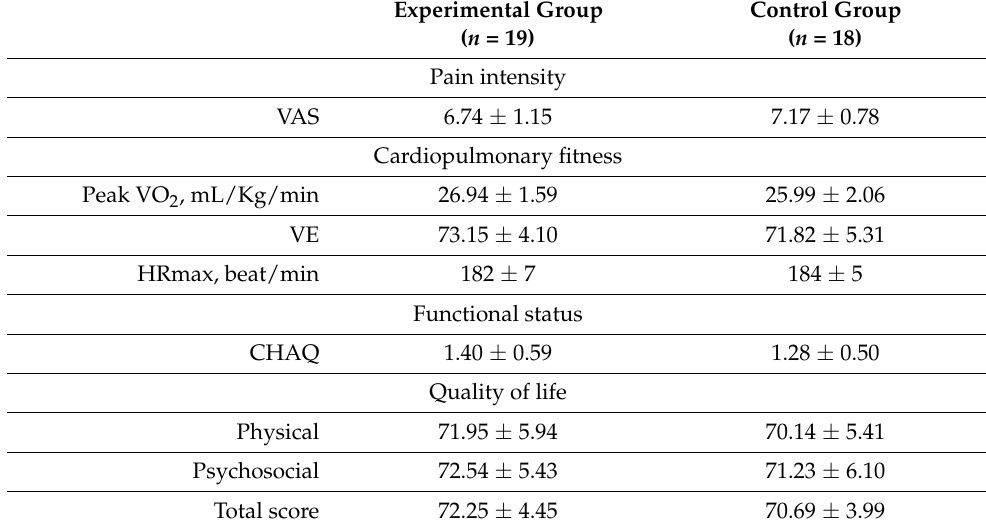
Table 3. Primary/secondary outcome measures in the experimental and control group at the pre- treatment